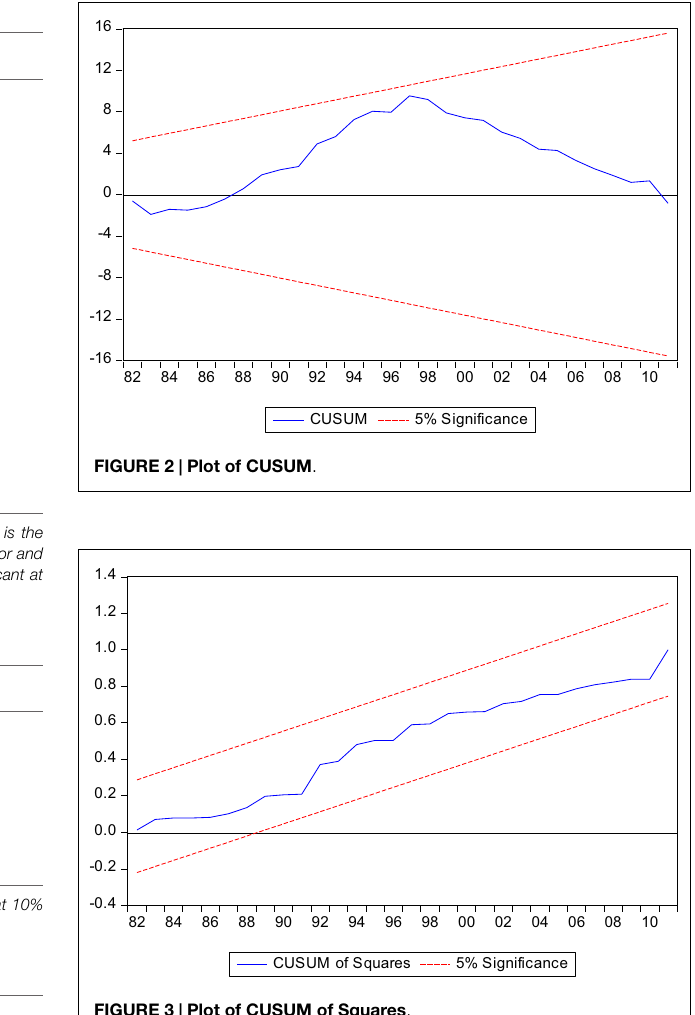
FIGURE 3 | Plot of CUSUM of Squares